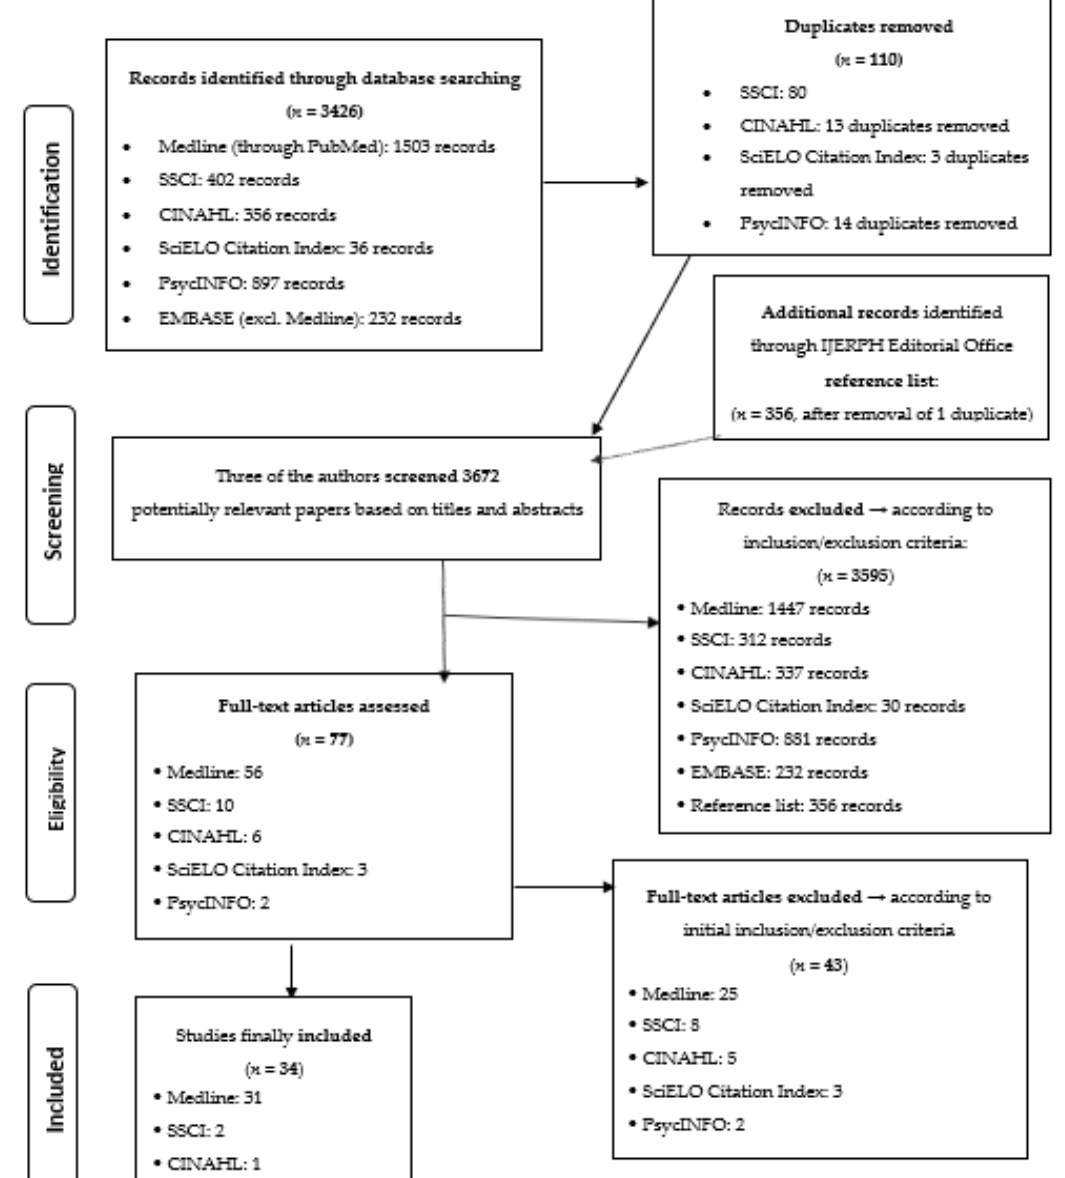
Figure 1. Flow diagram depicting the different phases of the scoping review about occupational health and safety of immigrant workers in Italy and Spain (1999–2018).